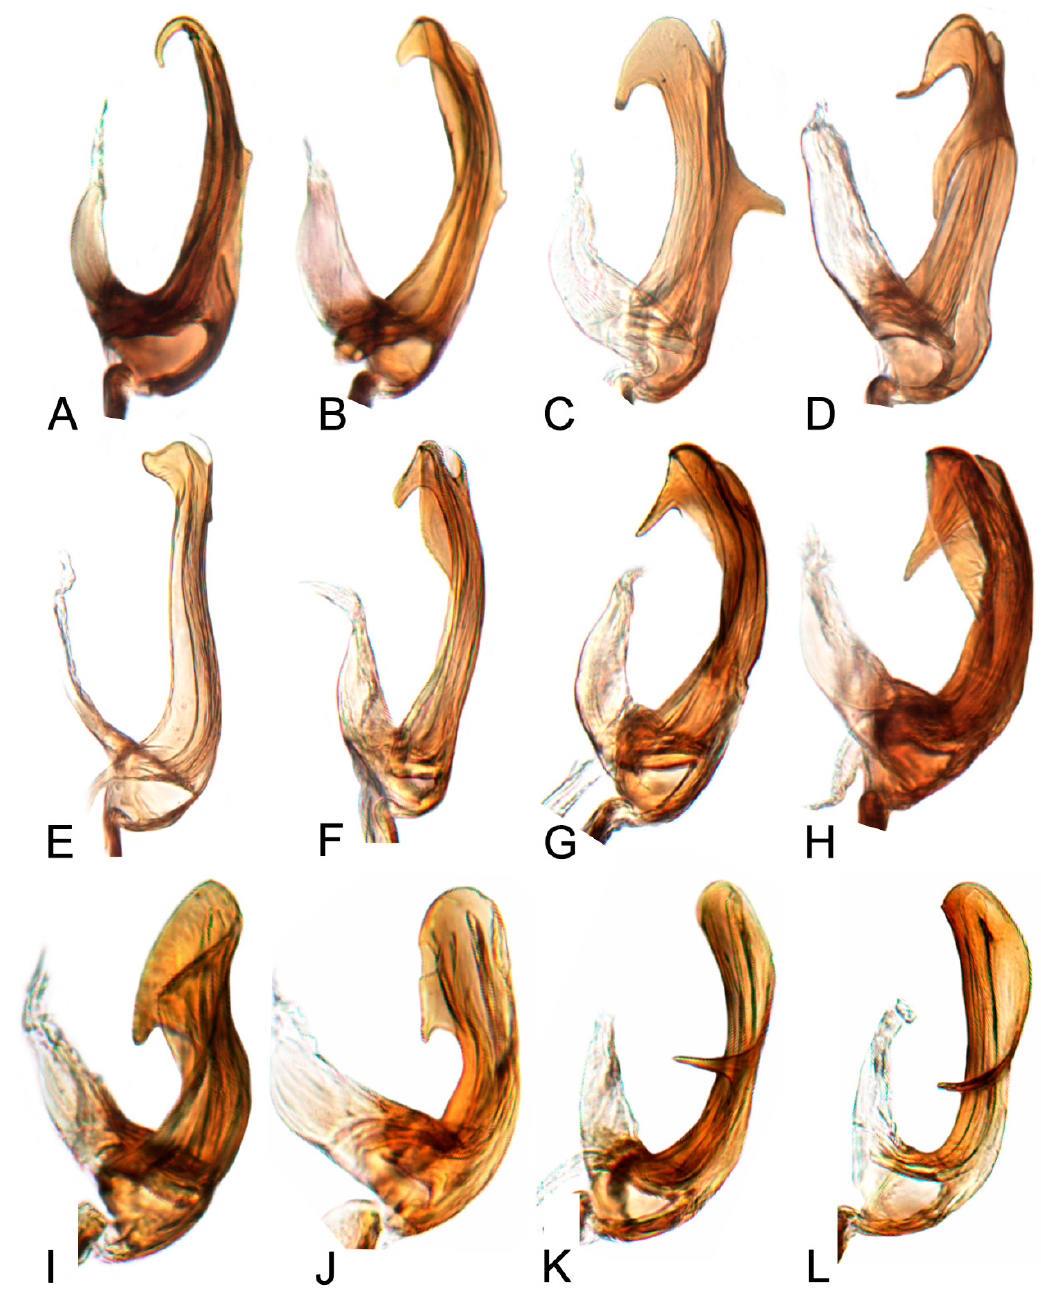
Figure 21. Aedeagus, lateral view. ( A ) H. di ff ractus ; ( B ) H. expansivus ; ( C ) H. ventralis; ( D ) H. hamuleus ; ( E ) H. yuanmouensis ; ( F ) H. hamatus ; ( G ) H. fuscomaculatus ; ( H ) H. lii ; ( I ) H. phycitis ; ( J ) H. paraphycitis ; ( K ) H. viraktamathiellus ; and ( L ) H. triangulus .